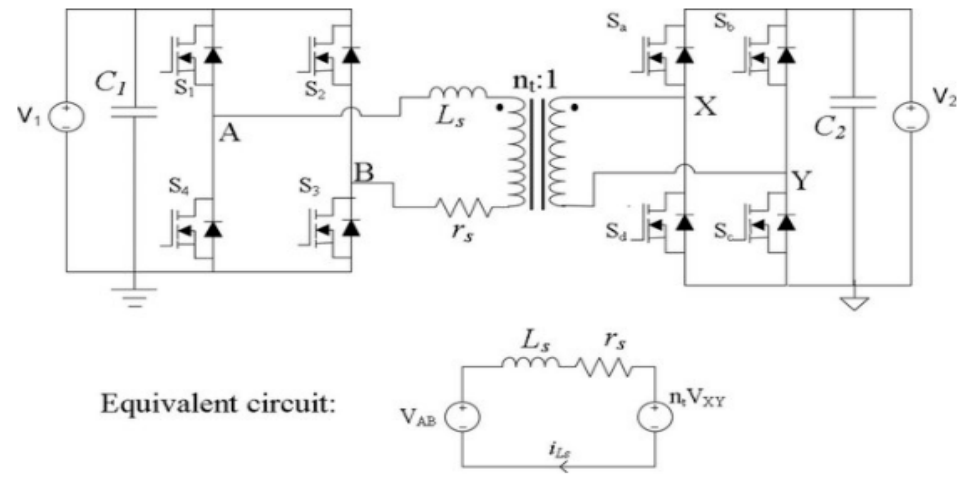
Figure 9. A Dual Active Bridge Converter for Charging Stations [48].